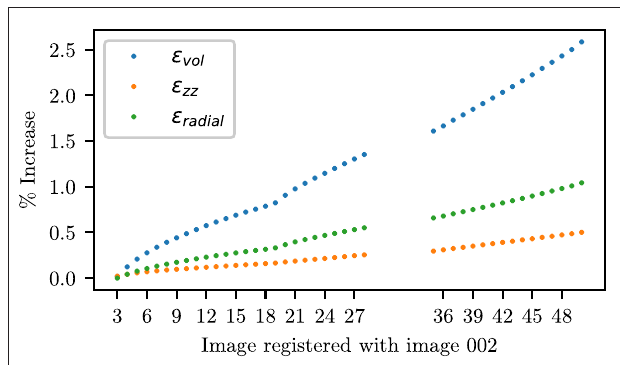
FIGURE 6 | Vertical and volumetric deformations obtained from registrations (i.e., a correlation yielding a single 8 for the entire 3D volume) with µ x fields with state 002. Each tomography takes